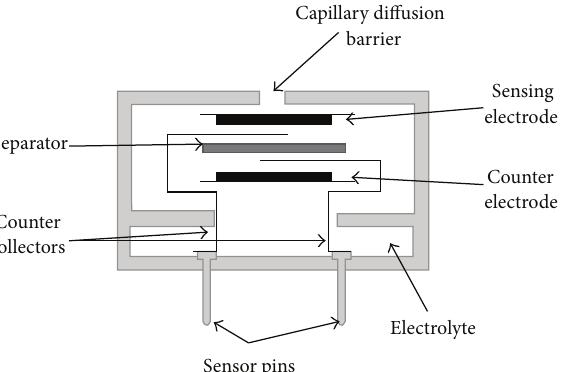
Figure 4: Internal sensor structure of CO 2